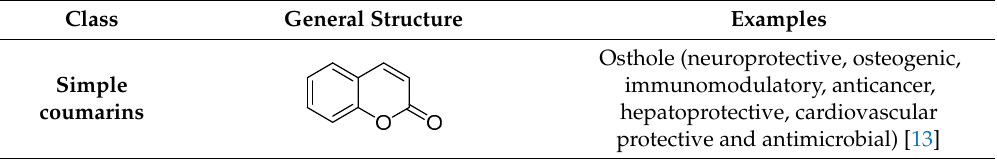
Figure 1. Structure of coumarin nucleus.